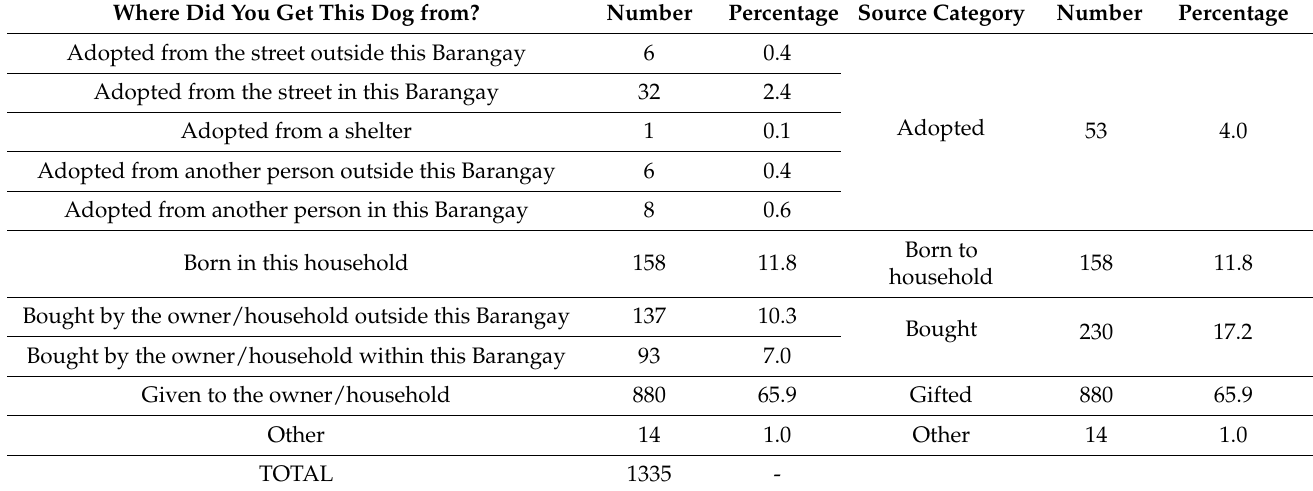
Table 4. Number and percentage of dog’s acquisition by pet owners in Quezon